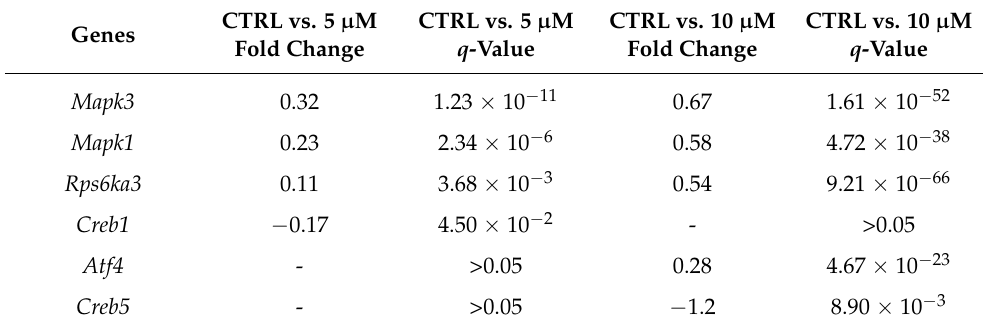
Table 3. DEGs of ERK and activation of Creb.